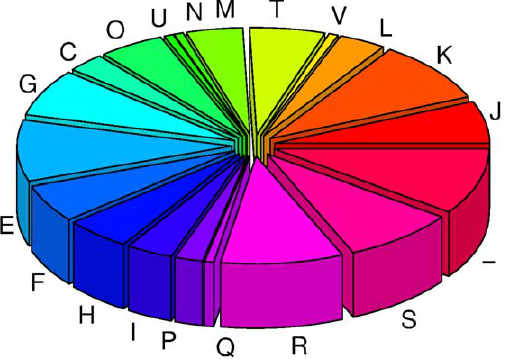
Figure 7. COG functional categories of the 125 genes involved in ON2010-specific recombination. The functional categories are